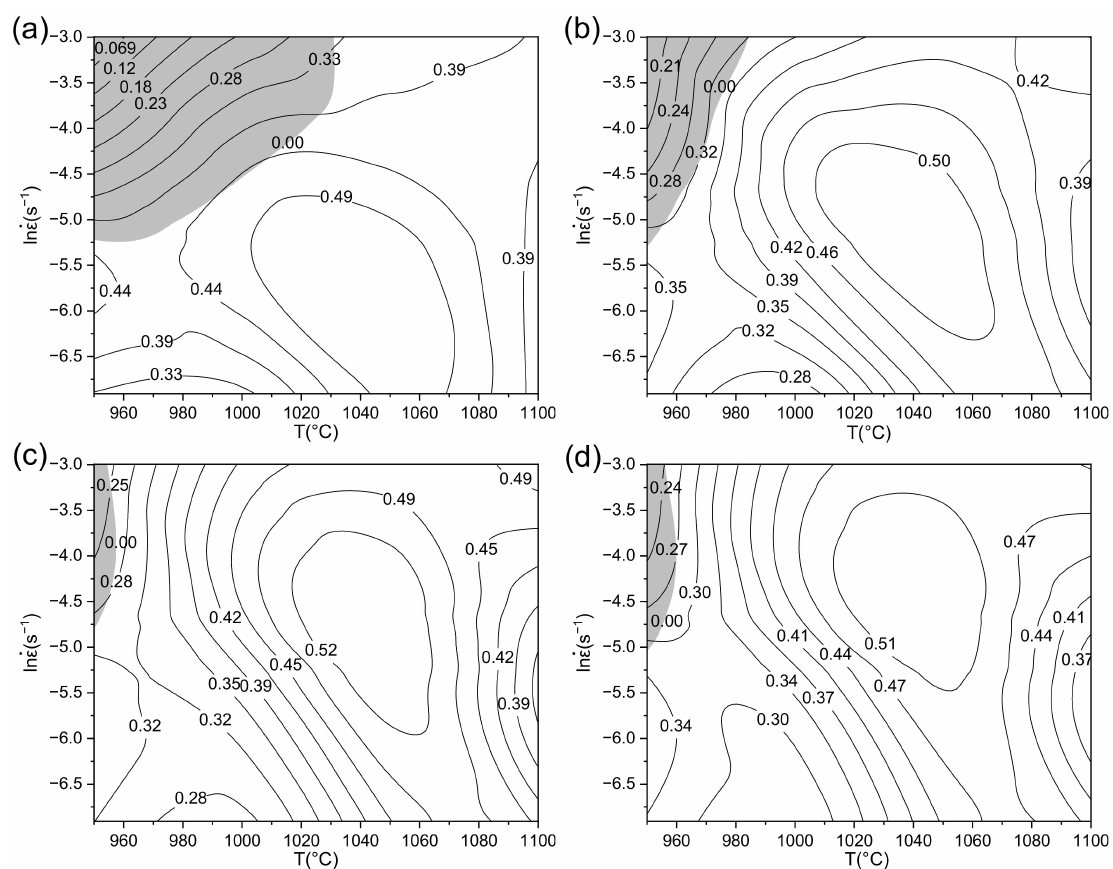
Figure 8. Thermal processing map of Inconel 625 under different effective strain. ( a ) ε = 0.2, ( b ) ε = 0.3, ( c ) ε = 0.5, ( d ) ε =